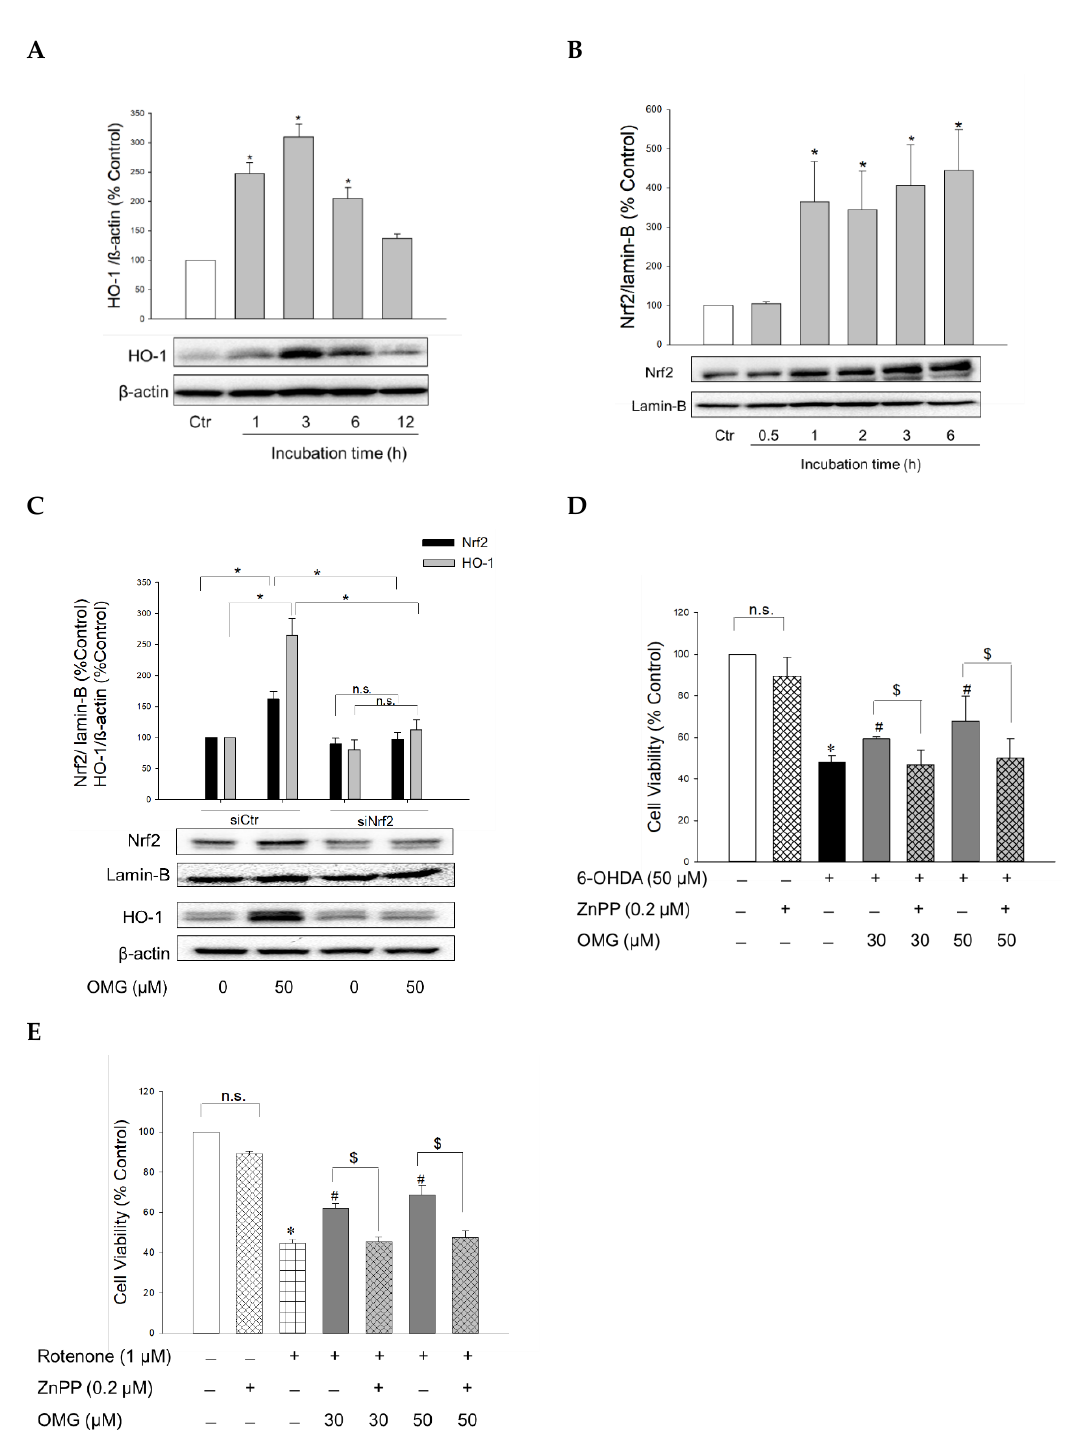
Figure 5. Activation of Nrf2/HO-1 signaling by OMG and its role in 6-OHDA- or rotenone-induced toxicity in PC12 cells. ( A , B ) PC12 cells were treated with OMG at 50 µM at the indicated time points, and the expression levels of ( A ) cytosolic HO-1 and ( B ) nuclear Nrf2 were evaluated by western blotting as described in the Materials and Methods section. Band intensities were quantified by densitometric analyses, and the cytosolic and nuclear proteins were normalized to β-actin and lamin-B, respectively. Data are displayed as the mean ± SEM from at least three independent experiments. *, p < 0.05 vs. vehicle-treated control cells. ( C ) PC12 cells were transfected with 100 nM of control siRNA (siCtr) or Nrf2-targeted siRNA (siNrf2) for 48h and then treated with 50 µ M OMG for an additional 6 h. Nuclear Nrf2 and cytosolic HO-1 levels were analyzed by western blotting, as described in the Materials and Methods. Band intensities were quantified by densitometric analyses, and the